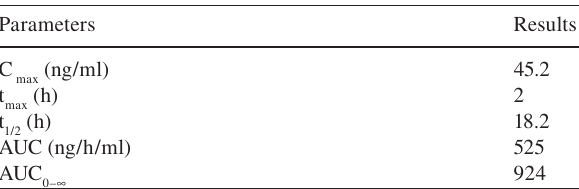
Pharmacokinetic parameters of desipramine as active metabolite of imipramine in